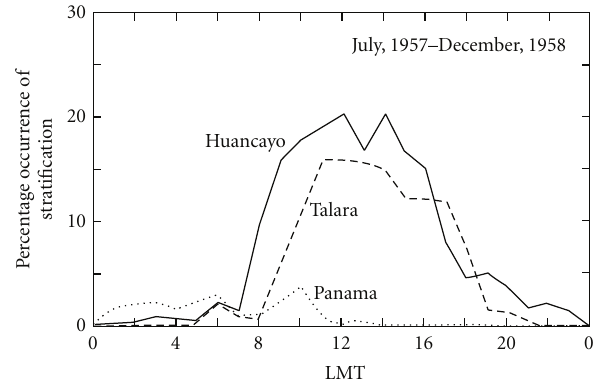
Figure 3: Diurnal variation of percentage occurrence of the F2 layer stratification during the IGY period (from Huang